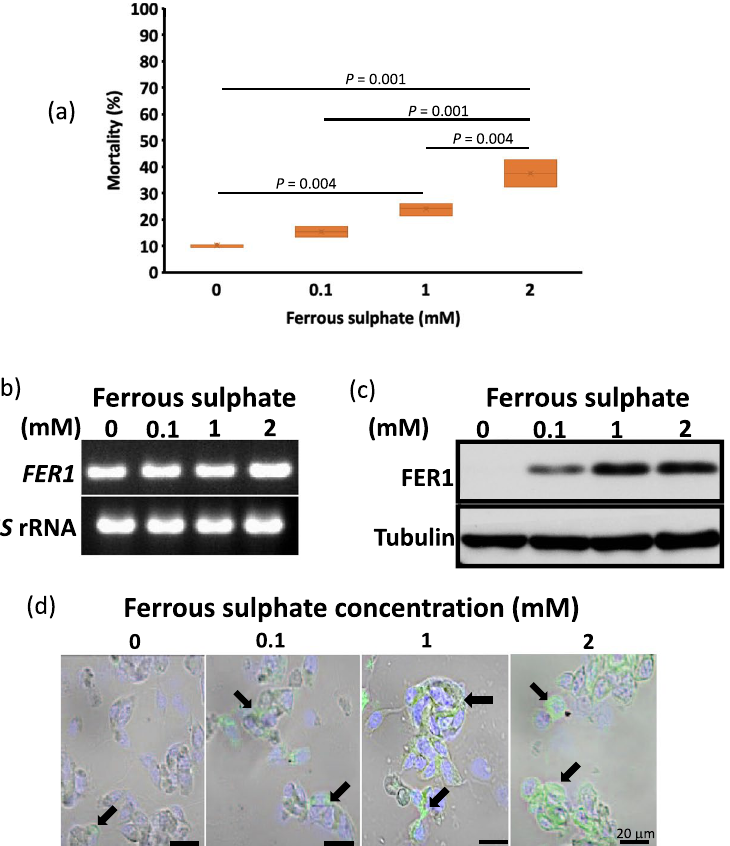
Figure 3. ( a ) Box and whisker plot showing the distribution of mortality in percentage of ISE6 cells exposed to different concentrations of ferrous sulphate for 48 h. Two hundred and fifty microliters of 1 × 10 6 cells/ml was transferred to a 48-well plate and incubated overnight. The next day, the media were replaced by ferrous sulphate–enriched media at different concentrations (0, 0.1, 1, and 2 mM). Mortality was checked after 48 h using Trypan blue stain. A one-way ANOVA with Bonferonni multiple comparison tests was performed (Tables S5 and S6). ( b ) FER1 mRNA expression of ferrous sulphate (0, 0.1, 1, and 2 mM)–exposed cells for FER1 was observed using RT-PCR. 16S rRNA was used as a loading control. Full length gels are presented in Fig. S5. The RT-PCR result is representative of three separate experiments. ( c ) FER1 protein expression of ferrous sulphate (0, 0.1, 1, and 2 mM)–exposed cells for FER1 was observed using Western blotting. Anti-mouse tubulin was used as a loading control. Full length blots are presented in Fig. S2. The Western blotting result is representative of three separate experiments. ( d ) Localization of FER1 protein was observed using IFAT. Arrowheads indicate positive fluorescence. The IFAT result is representative of three separate experiments. Bar = 10 μ m. The data presented are results of three independent experiments with the Trypan blue staining performed in two technical replicates for each experiment.